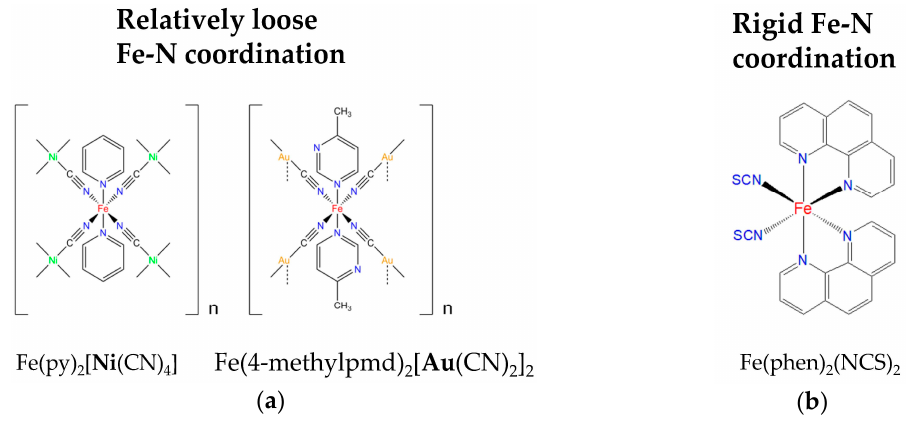
Figure 2. Molecular structures of ( a ) Hofmann-like SCO polymers of Fe(4-methylpmd) 2 [Au(CN) 2 ] 2 and (Fe(py) 2 [Ni(CN) 4 ]), and ( b ) a reference Fe(phen) 2 (NCS) 2 .